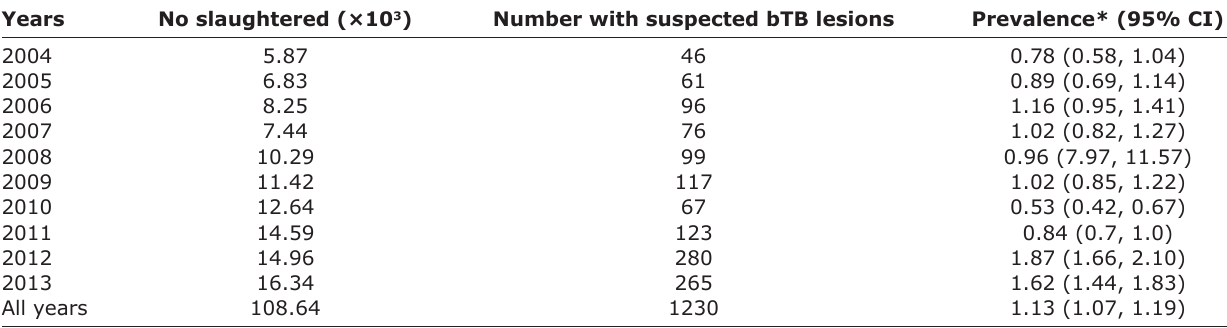
Table-1: Annual distribution of gross bTB lesions observed among slaughtered cattle in Bauchi municipal abattoir, Nigeria (2004-2013). Years